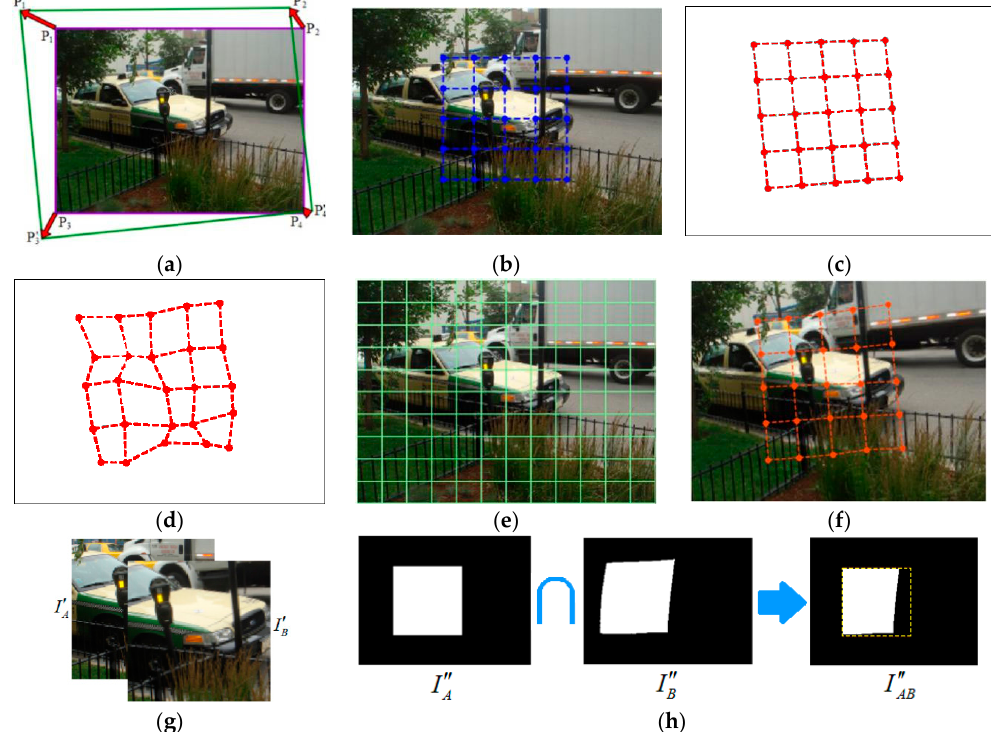
Figure 1. The process of the proposed sample and label generation method: ( a ) Generate four pairs of points and obtain the corresponding homography matrix H AB ; ( b ) randomly cut out the original image to generate an M × N uniform grid G A ; ( c ) M × N points G (cid:48) A transformed from G A by using H AB ; ( d ) M × N perturbation points (cid:102) G (cid:48) A generated from G (cid:48) A ; ( e ) adaptively generate m × n uniform grid; ( f ) image I B transformed from I A using local homography matrices H AB ; ( g ) generated alternative L samples; ( h ) calculation of overlap degree of two sample